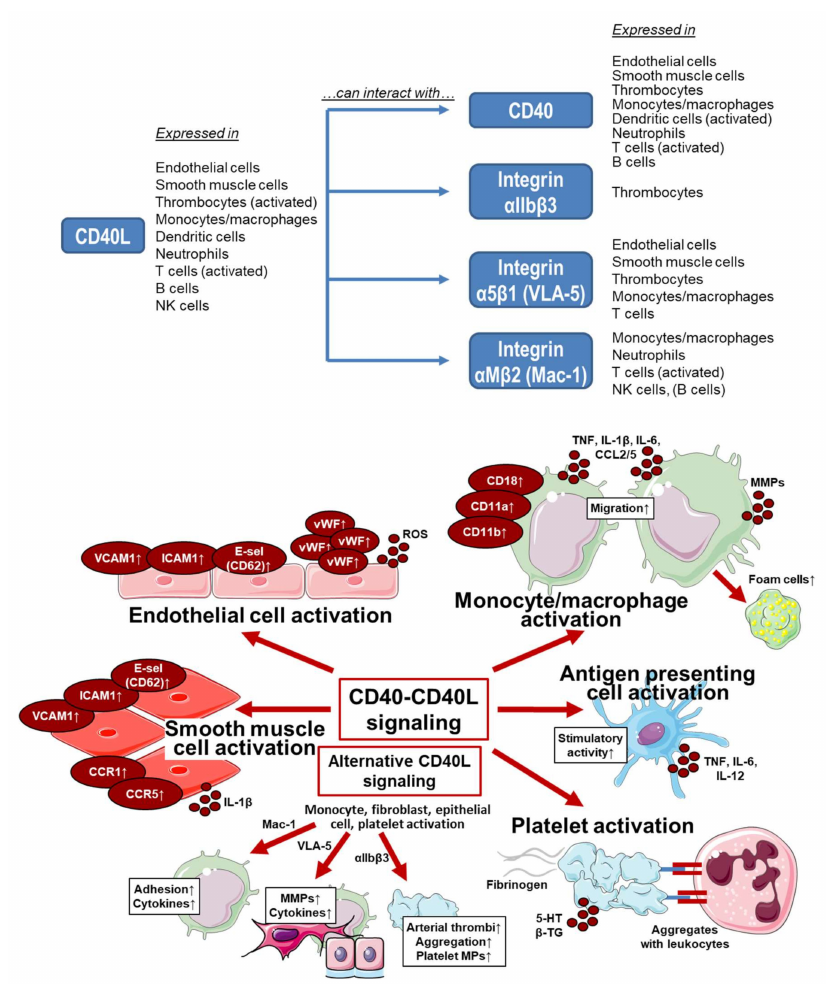
Figure 2. Upper panel: Overview on the expression of CD40L and its molecular targets and receptors in di ff erent cell types as well as potential interactions. Summarized from information in [52,61–64]. Lower panel: E ff ects on CD40–CD40L and alternative signaling on di ff erent cell types. VCAM, vascular cell adhesion molecule; ICAM, intercellular adhesion molecule; E-sel, E-selectin (CD62); vWF, von Willebrand factor; ROS, reactive oxygen species; CD, cluster of di ff erentiation; CD11a, integrin α L; CD11b, integrin α M; CD18, integrin Mac-1; TNF, tumor necrosis factor; IL, interleukin; CCL, CC-chemokine ligand; MMPs, matrix metalloproteinases; CCR, CC chemokine receptor; VLA-5, fibronectin receptor; α IIb β 3, glycoprotein GPIIb / IIIa (CD41 / CD61), an integrin; MPs, microparticles; 5-HT, serotonin; β -TG, β -thromboglobulin. Summarized from table in [61] with permission. Contains images from Servier Medical Art by Servier, licensed under a Creative Commons Attribution 3.0 Unported